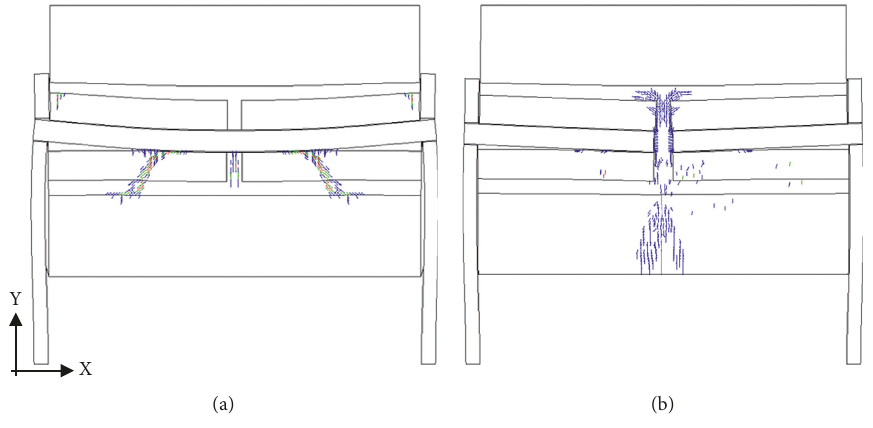
Figure 12: Failure crack pattern of FE models 1-bar (a) and 2-bar (b). Deformed shape factor